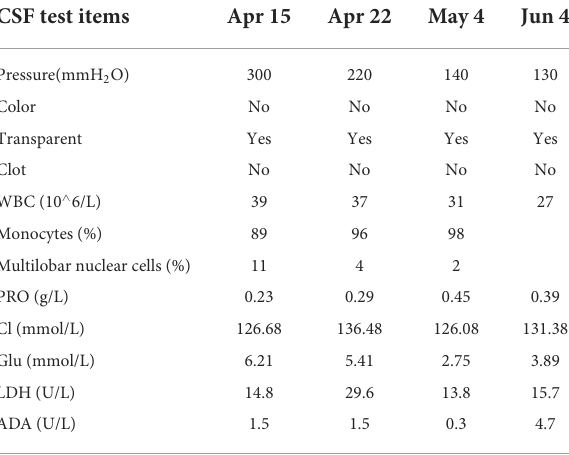
TABLE 2 Cerebrospinal fluid examination results of patients with pseudorabies virus